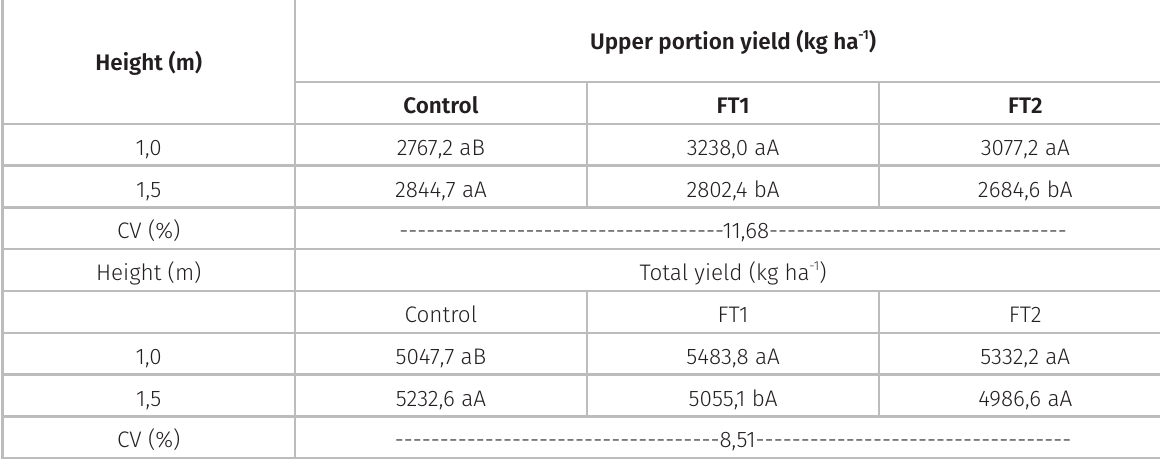
Averages followed by the same letter, lowercase letter in the columns and capital letter in the lines, do not differ among themselves by Scott-Knott’s test at 5% of probability. *Control; FT1- Active ingredients and sprays starting at B1 stage with interval of 15 days until 75 days (Piraclostrobin + Fluxapyroxad (B1), Trifloxystrobin + Prothioconazole (B1+15), Piraclostrobin + Fluxapyroxad (B1+30), Piraclostrobin + Fluxapyroxad (B1+45), Piraclostrobin + Fluxapyroxad (B1+60), Trifloxystrobin + Prothioconazole (B1+75)); FT 2- Active ingredients and sprays starting at B1 stage with interval of 15 days until 75 days (Azoxistrobin + Difenoconazole (B1), Difenoconazole (B1+15), Azoxistrobin + Difenoconazole (B1+30), Azoxistrobin + Difenoconazole (B1+45), Azoxistrobin + Difenoconazole (B1+60), Difenoconazole